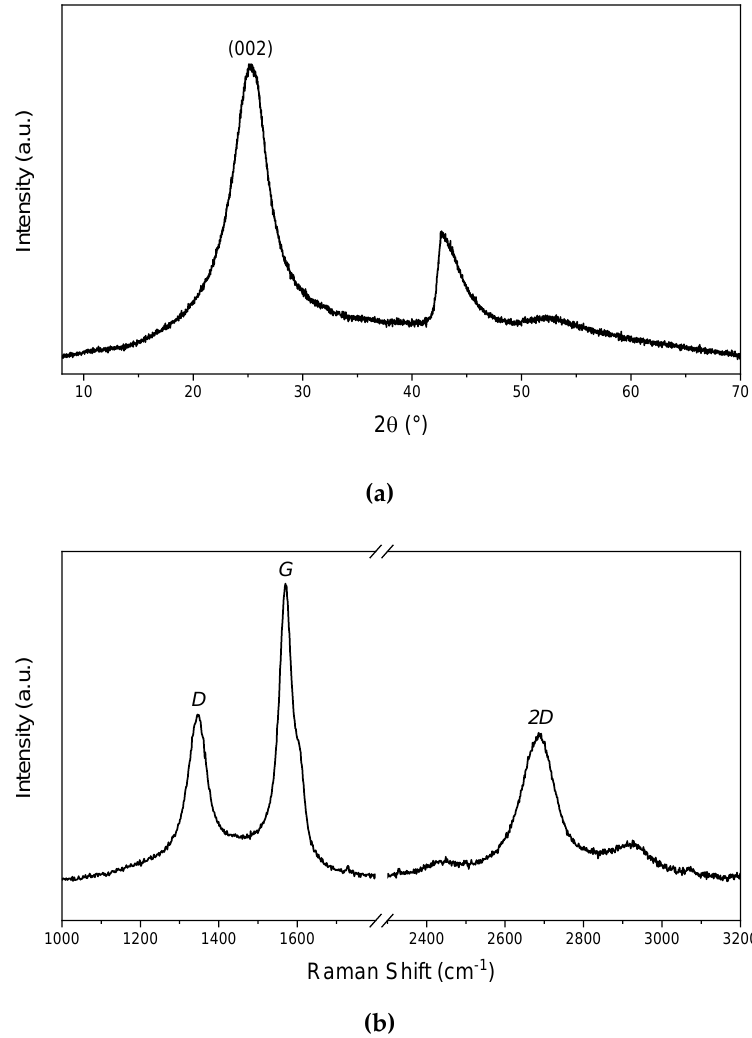
Figure 4. ( a ) X-ray diffraction pattern and ( b ) Raman spectrum of FGO.